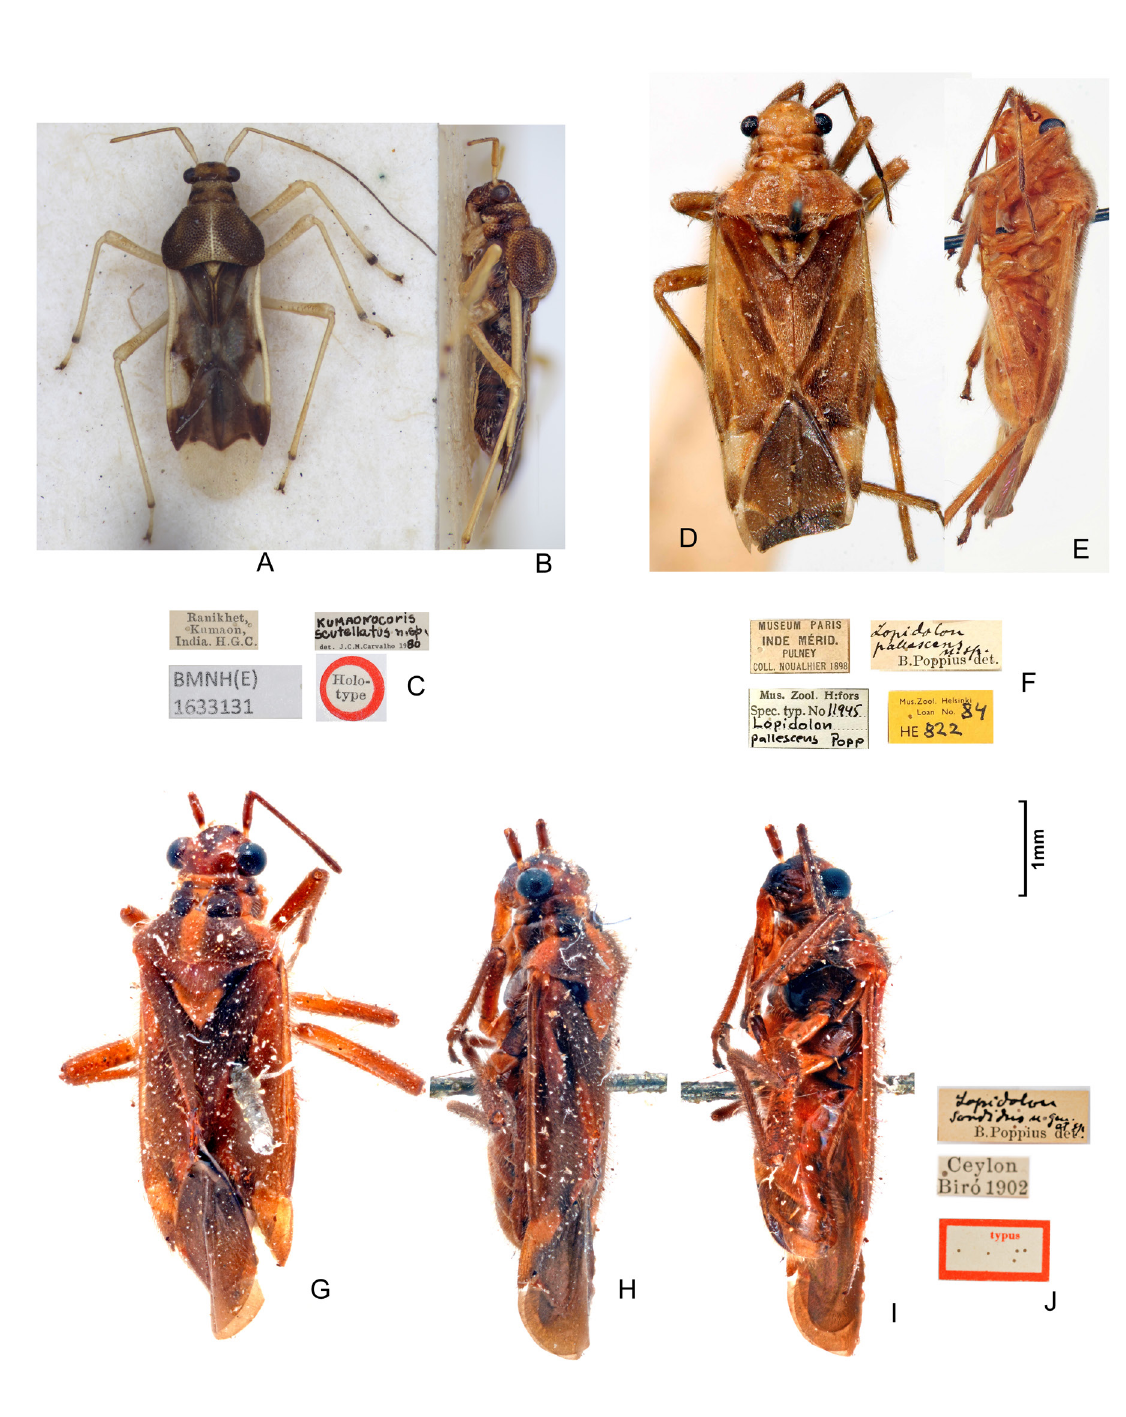
Fig. 6. Dorsal view and label data of type specimens. A–C . Jessopocoris scutellatus Carvalho, 1981, ♀, holotype, AMNH_PBI 00340984, BMNH(E) 1633131, NHM. D–F . Lopidolon pallescens Poppius, 1911, ♀, holotype, FMNH, currently retained at AMNH. G–J . Loidolon sordidus Poppius, 1911, ♀, holotype,